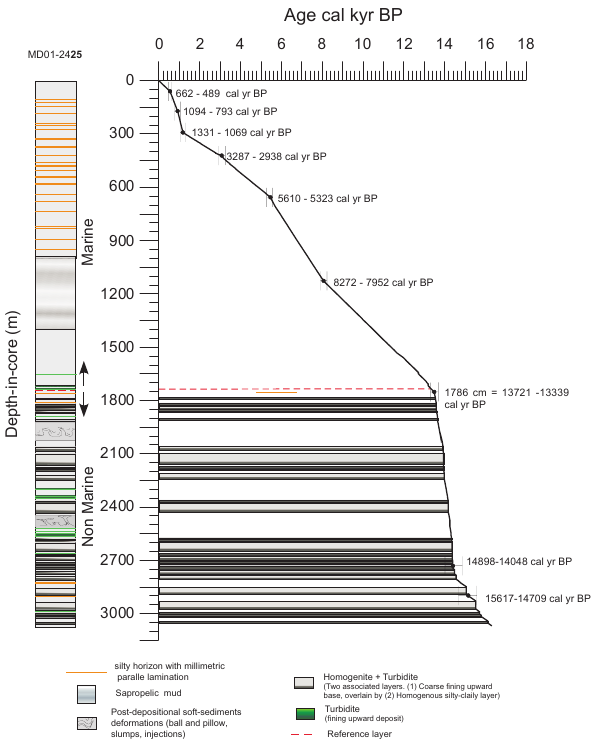
Figure 2. Age/depth curve of core MD01-2425 (Çinarcik Basin) displaying major instantaneous deposits (homogenite + turbidite). Red dashed line indicates the limit between nonmarine (below) and marine sequences (reference layer displayed in Figs. 3 and 5); pLGH: pre-late glacial homogenite (Beck et al.,